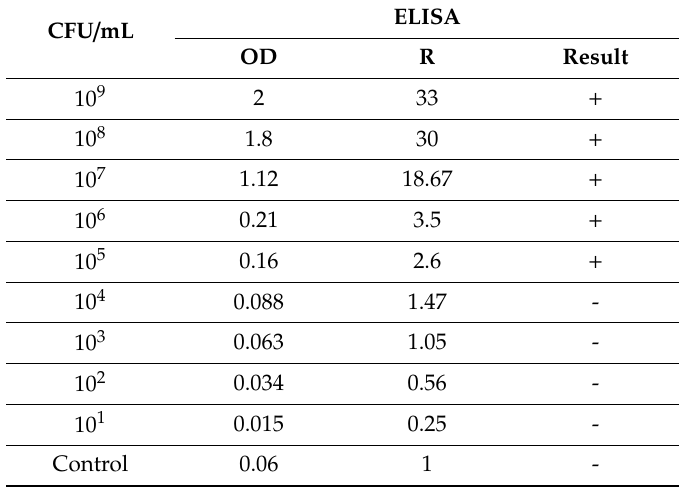
Table1. Resultsofenzyme-linkedimmunosorbent-assay(ELISA)tests( − = negative, +=